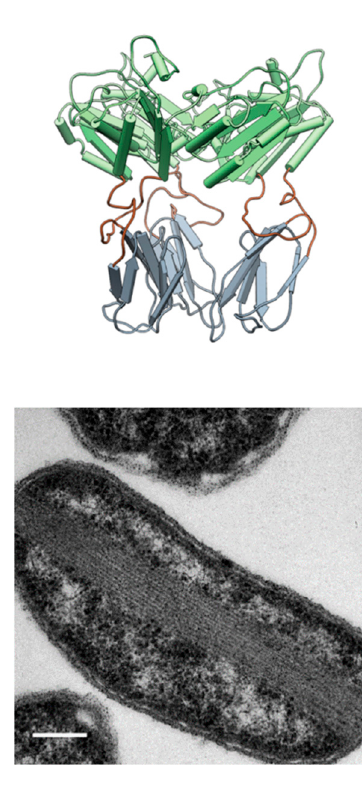
Figure 6. Repurposing BMCs and BMC components into scaffolds for enzyme catalysis. ( A ) Model of the HO-BMC, with BMC-H colored blue, BMC-P yellow, and BMC-T green. Reprinted from Kerfeld and Kirst [97]. Copyright 2019 Springer Nature. ( B ) Grafting of the SpyCatcher (below, grey) domain into a loop region within the HO-BMC-T protein (top, green) for covalent conjugation of protein cargo. Reprinted from Kerfeld and co-workers [54]. ( C ) The alpha-carboxysome has been repurposed for hosting the hydrogenase enzyme, HydA, and a ferredoxin-NADP(+) oxidoreductase (FNR) to produce molecular hydrogen. Reprinted from Liu and co-workers [93]. ( D ) PduA*, a variant of the PduA BMC-H protein, forms elongated rod-like structures within E. coli , which can be modified to host enzymes. Reprinted from Warren and co-workers [95]. Copyright ( B ) 2018, ( C ) 2020, and ( D ) 2017 Nature